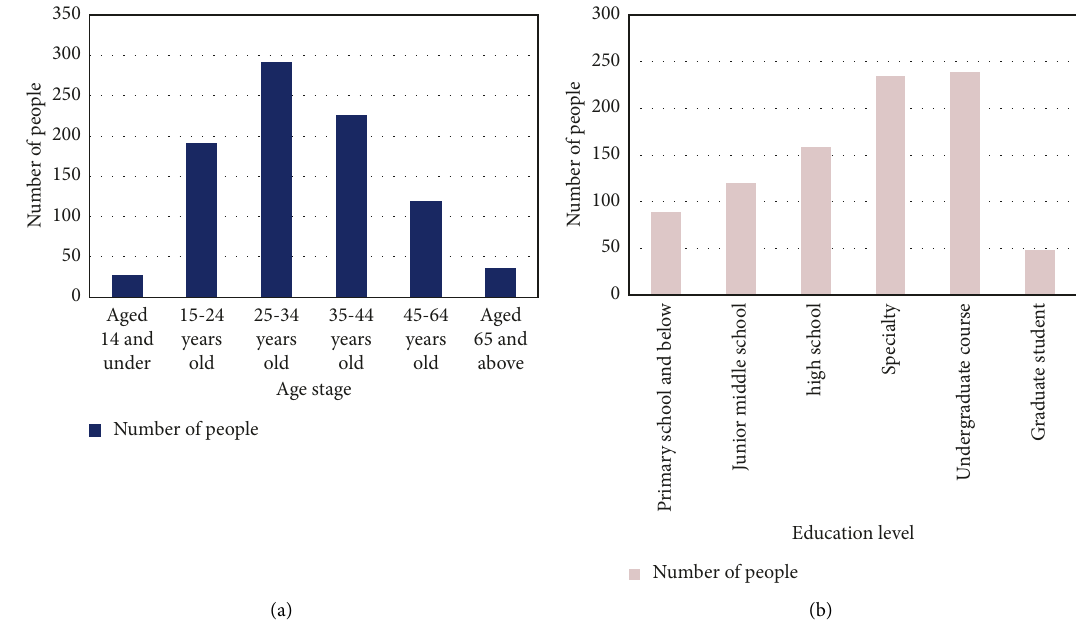
Figure 7: Statistical (a) analysis of (b) consumer situation.